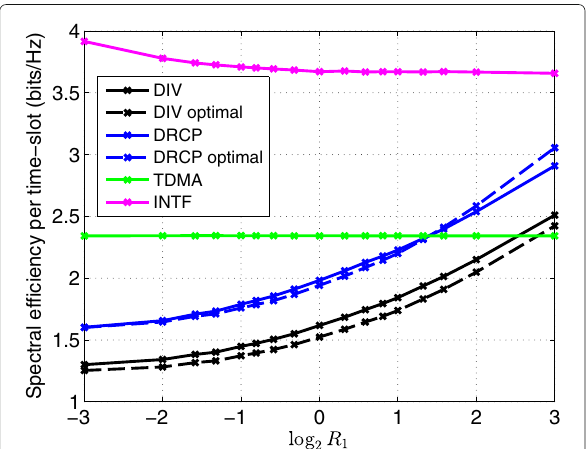
Fig. 5 Success rate of the studied approaches in the transmit power-dominated regime with S min 1 = S min 1 = 0.3 bits/Hz